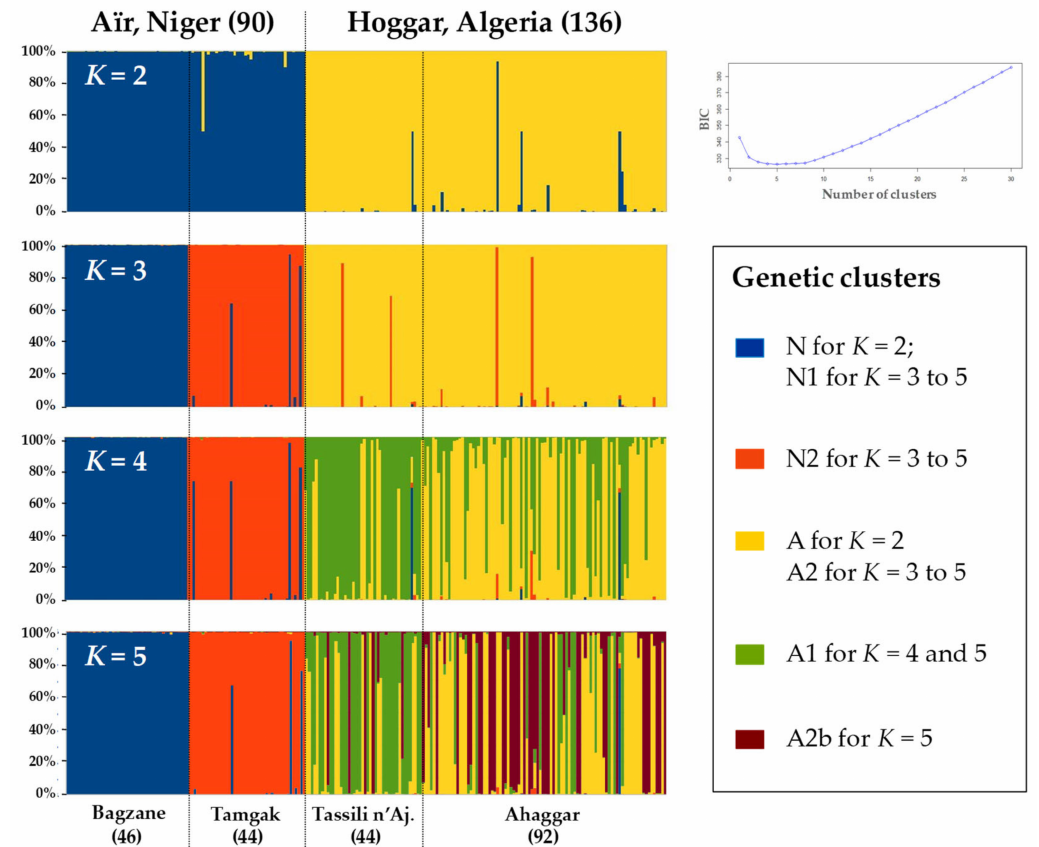
Figure 4. Inference of population structure using Bayesian simulations with snapclust [50] based on 226 SSR genotypes with no missing data. On the right, Bayesian Information Criterion (BIC [53]) values over 20 iterations per K indicate that the best K value is 5. On the left, barplots of the snapclust analyses based on K = 2 to 5 are shown. The percentage ( p ) of assignment of each individual to gene pools averaged over 20 iterations is shown. Each individual is represented by a vertical bar. The four main massifs are indicated as predefined regions. At K = 2, most individuals are correctly assigned to Aïr (N) or Hoggar (A) clusters. At K = 3, two gene pools are distinguished in Niger (N1 for Bagzane, and N2 for most individuals sampled in Tamgak). Finally, at K = 4 and 5, the Hoggar cluster is split into clusters (A1 and A2; or A1, A2 and A2b) that poorly match to each massif, suggesting a low differentiation between Tassili n’Ajjer (Tassili n’Aj.) and